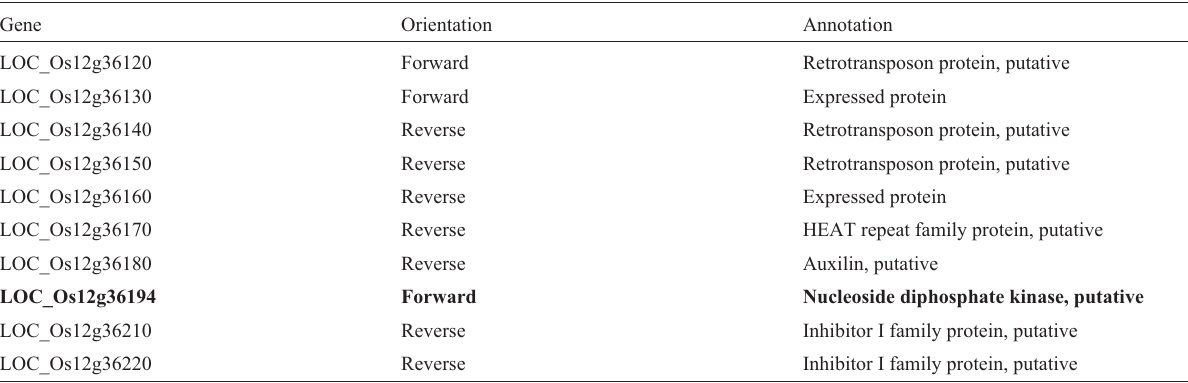
Table 3 - Gene prediction within the 62.4 kb region delimited by markers. Gene